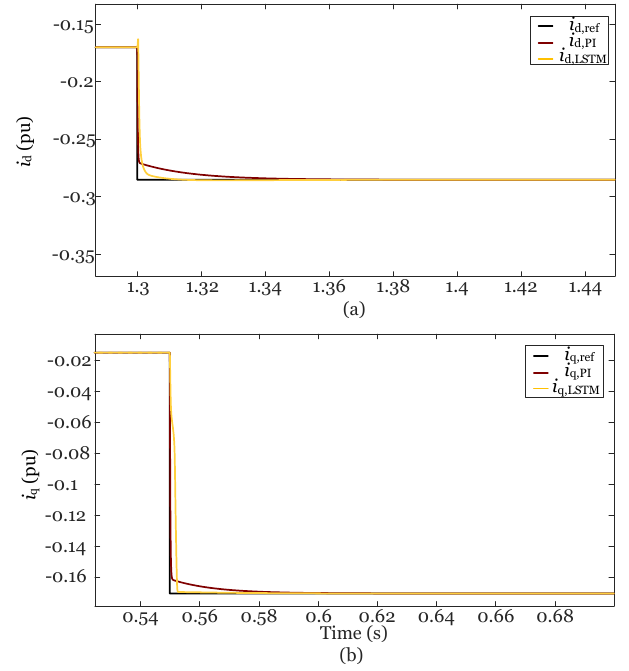
Figure 14. Controller response for a lower SCR. ( a ) i d , ref change; ( b ) i q , ref